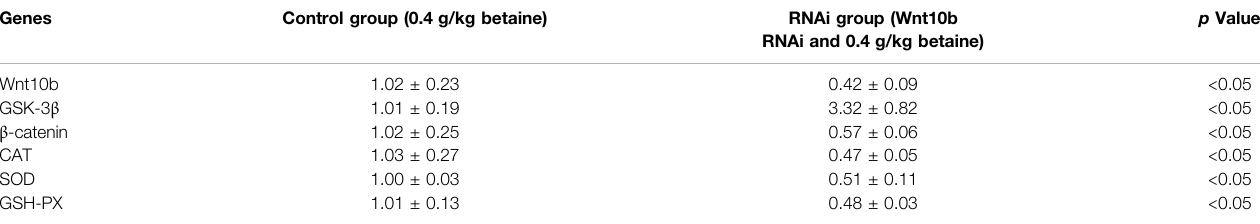
TABLE 4 | Effect of Wnt10b RNA interference on the gene expression level in the liver of zebra fi sh. Genes Control group (0.4 g/kg betaine) RNAi group (Wnt10b